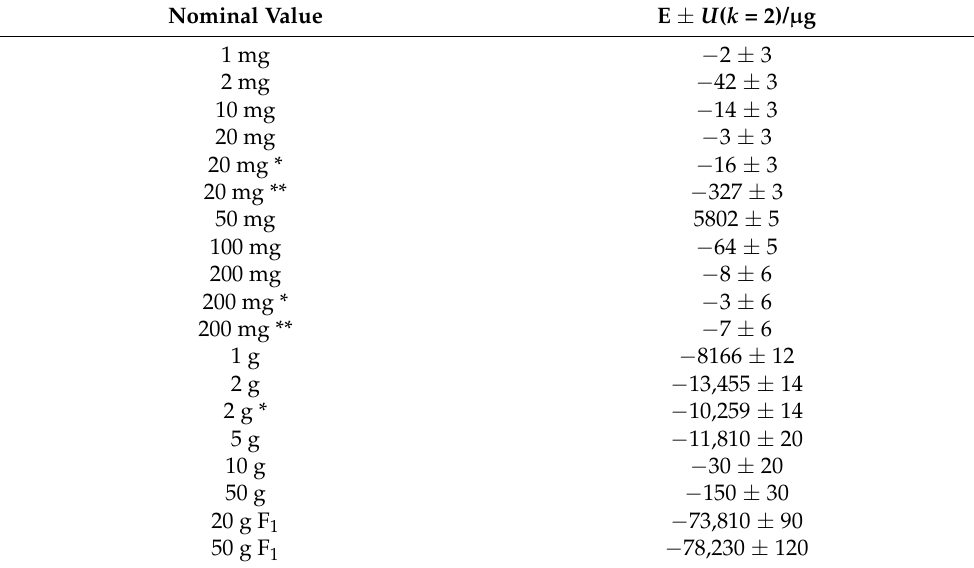
Table 1. Calibration error (E) and expanded uncertainty U ( k = 2) for standard weights, * and ** represent marking on the weight surface used to distinguish weights with the same nominal